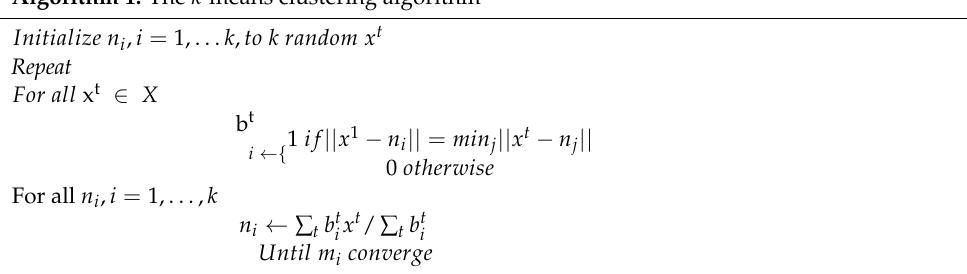
Algorithm 1. The k -means clustering